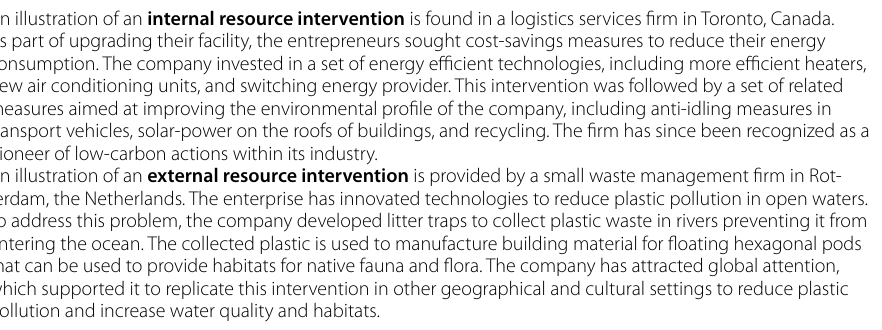
Table 2 Illustrative examples of parameter resource interventions An illustration of an internal resource intervention is found in a logistics services firm in Toronto, Canada. As part of upgrading their facility, the entrepreneurs sought cost-savings measures to reduce their